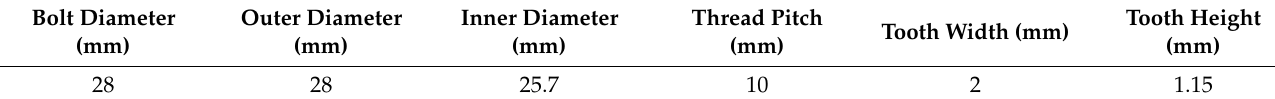
Table 2. Test bolt shape parameters.